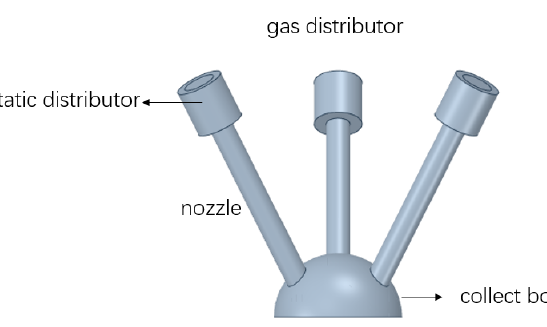
Figure 6. Schematic diagram of gas